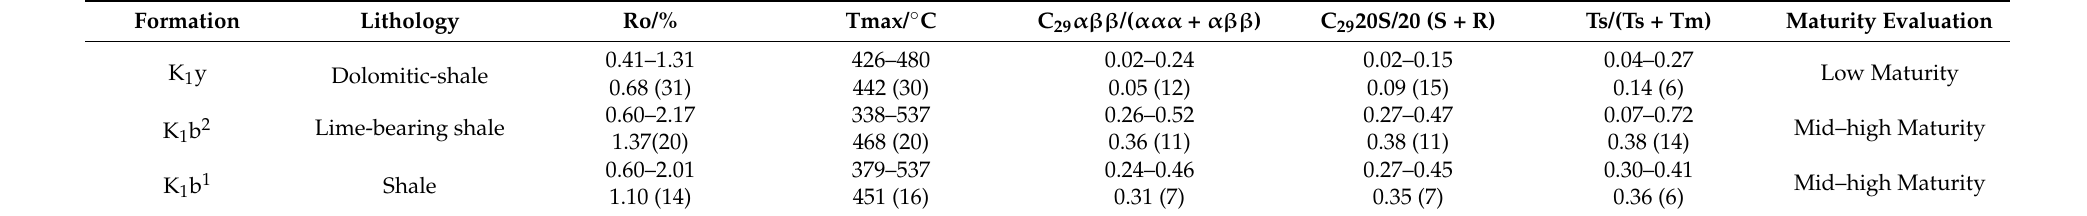
Table 4. Comprehensive Evaluation of Source Rocks in the Hari